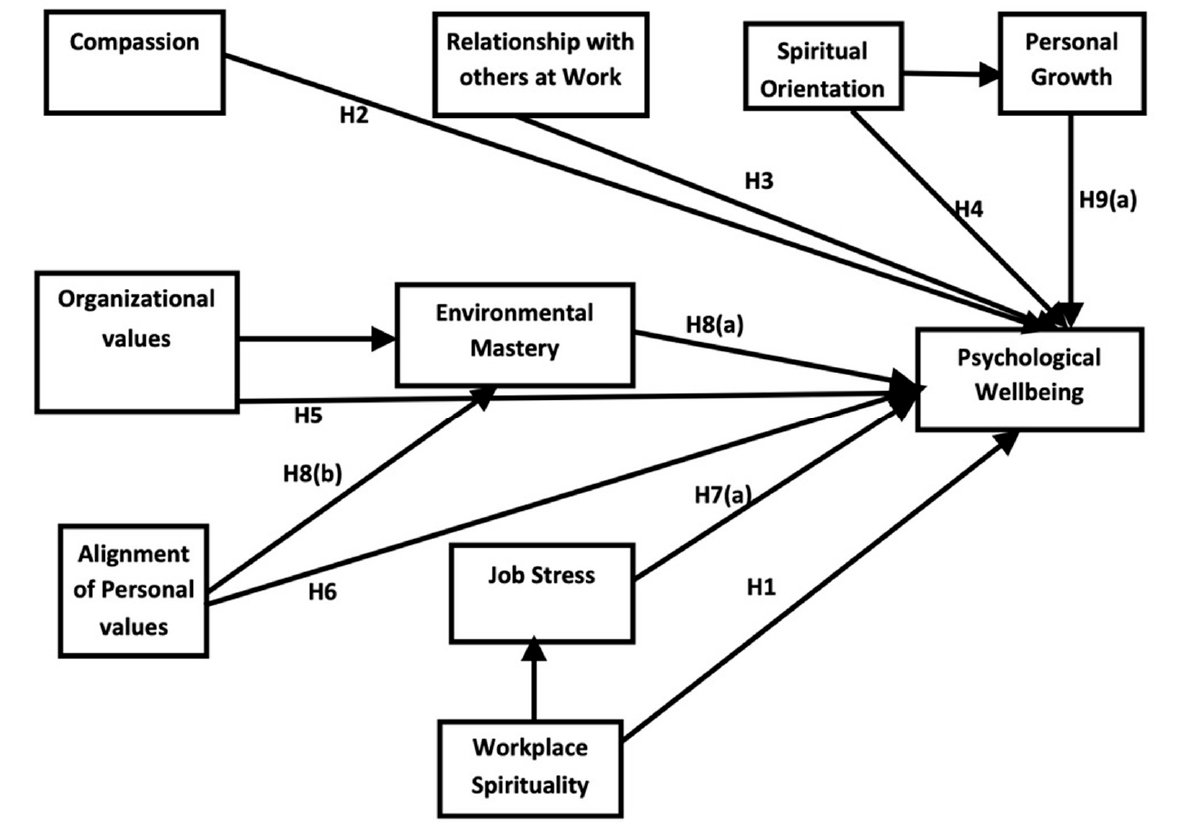
Figure 1. Theoretical and conceptual framework of the study. Source: Previous literature [21,29,33,34,39,41,44,47,77–84].